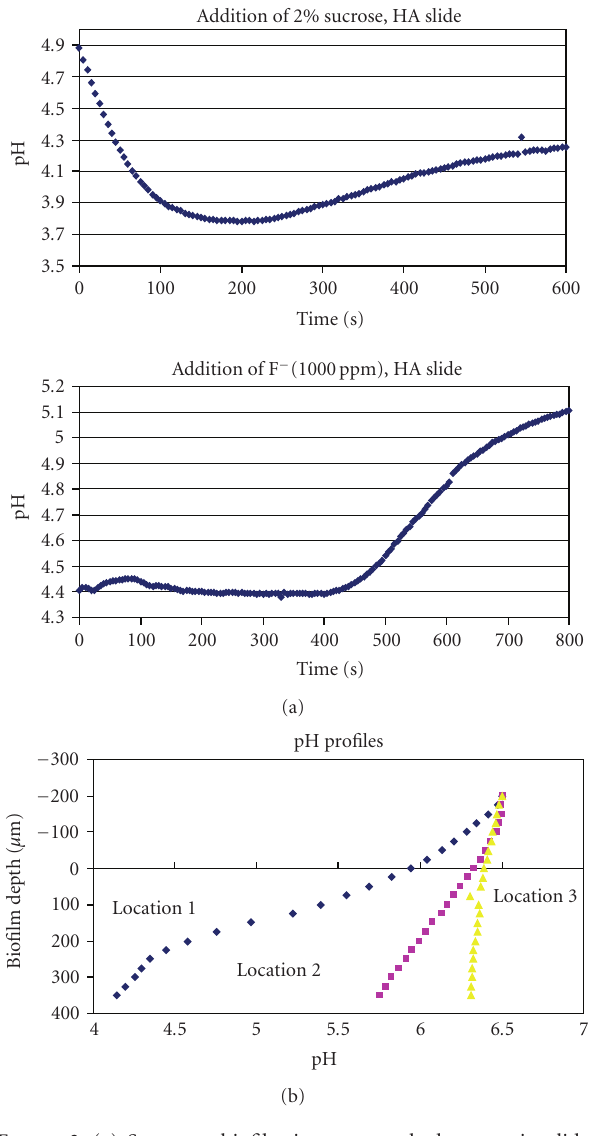
Figure 2: (a) S. mutans biofilm is grown on hydroxyapatite slides with microelectrode measurements revealing a drop in pH within the first 4 minutes after addition of 2 % sucrose. Removing sucrose and adding F raises pH after 6-7 minutes of intervention (graph redrawn from [5]). (b) Variability of microelectrode profiles within the biofilm after sucrose addition. In location 1 pH dropped to 4.2, while little change was seen in location